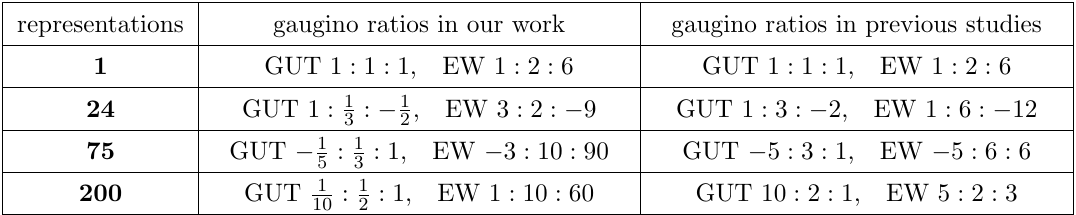
Table 1 . Comparison of our predictions with previous studies (e.g., ref. [62]) on gaugino mass ratios in di(cid:11)erent SU(5) representations, where ‘GUT’ is for results at GUT scale and ‘EW’ is for results at EW